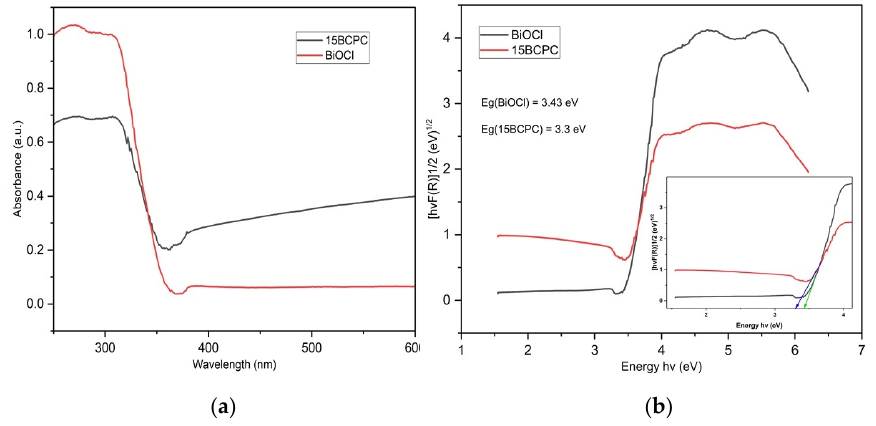
Figure 6. The UV–Vis diffuse Reflectance Spectra of BiOCl and 15BCPC ( a ) and the derived Tauc plots ( b ) for the estimation of the band gap.